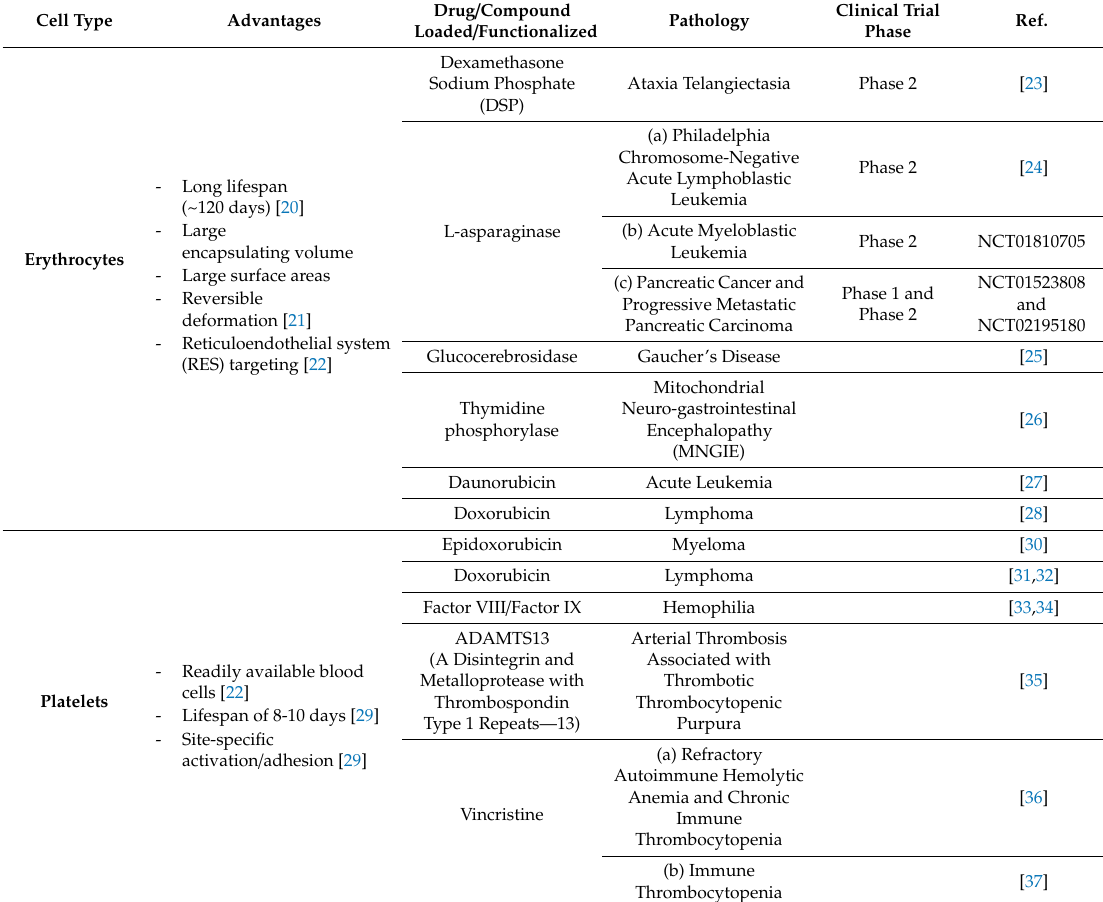
Table 1. Cells as drug delivery